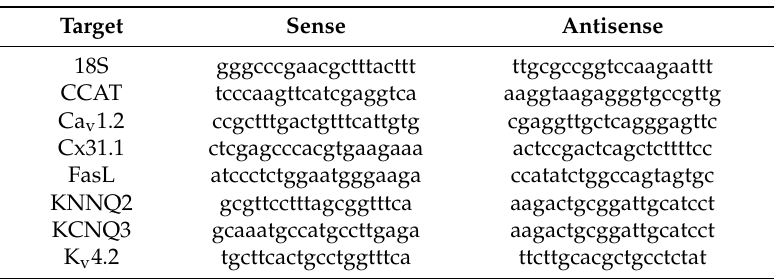
Table 1. List of primers.